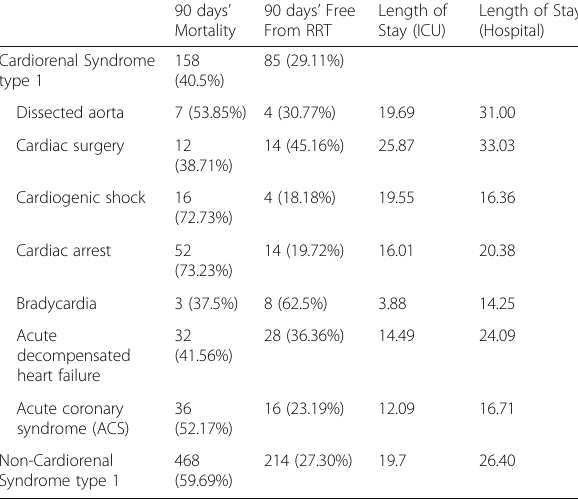
Table 1 (abstract 001265). 90 days ’ Outcomes of CRS-1 needing